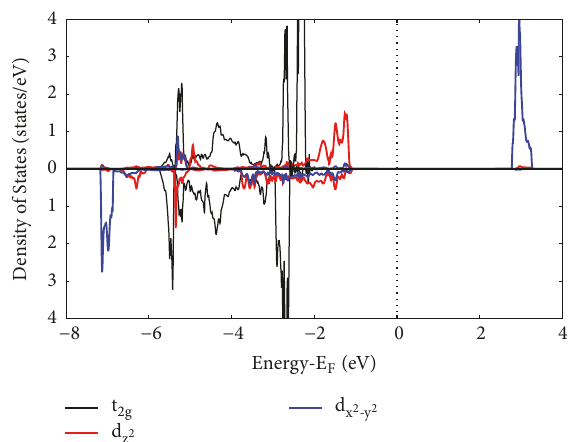
Figure 5: Projected density of stateson copper atoms of pure KCuF 3 determined at the B3LYP level of theory for the AF1 phase. DOS in arbitrary units. Upper and bottom panels refer to different spin components. For the sake of clarity, d , d , and d are grouped xy xz yz together and called “t 2 ” (black curve) while d (blue curve) and g x 2 - y 2 d (red curve) ones are drawn z 2